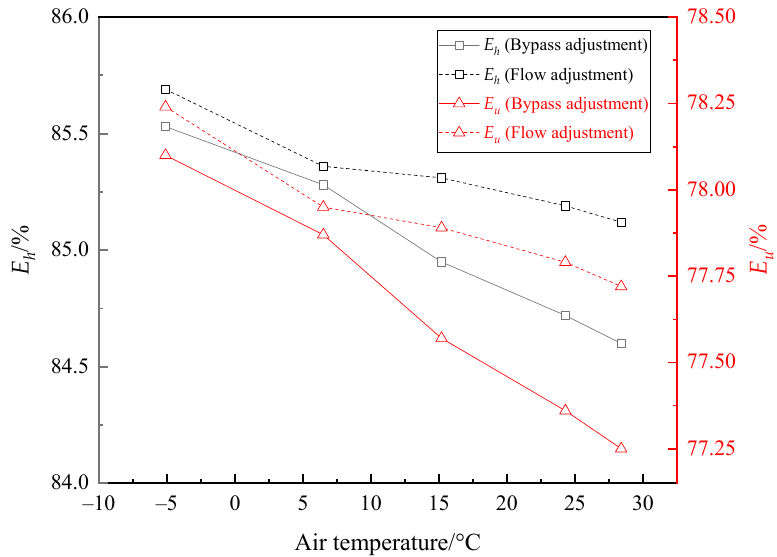
Figure 18. E h and E u as air temperature changed.